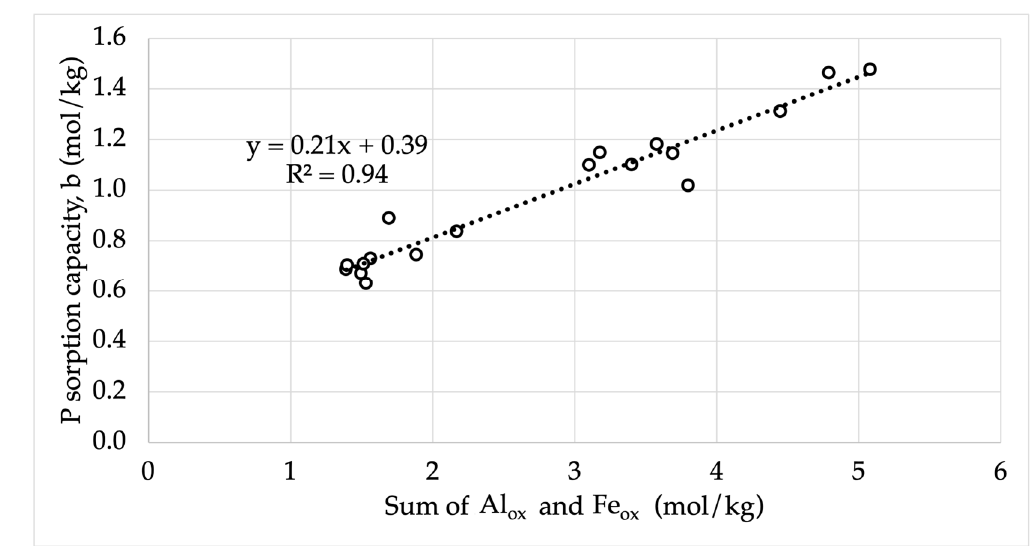
Figure 6. Maximum P sorption capacity (sum of b 1 and b 2 ) of DWTRs, as determined from two-surface Langmuir isotherm, plotted against sum of oxalate-extractable Al and Fe, with linear regression (n = 18).